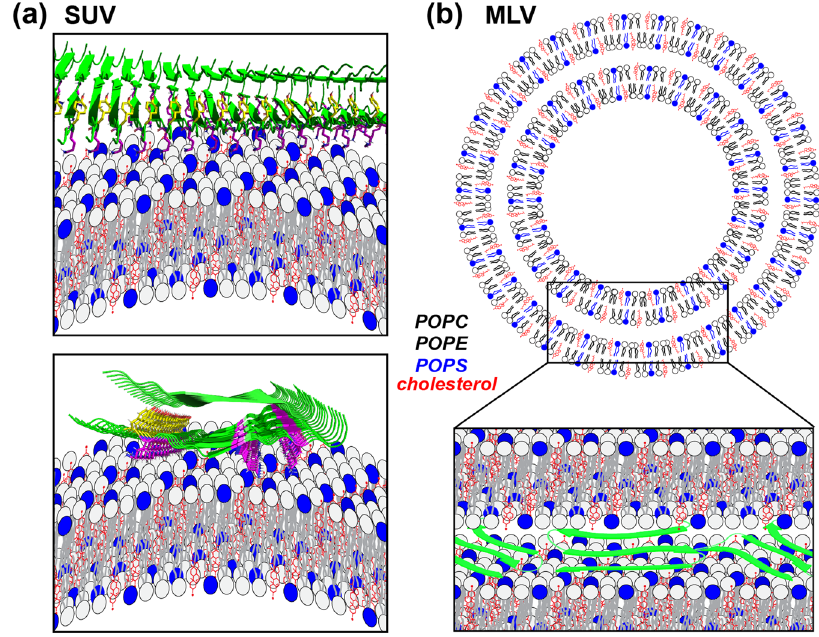
Fig. 6 Model of membrane-induced tau β -sheet assembly. a Binding tau monomers to preformed cholesterol-containing SUVs promote the formation of amyloid fi brils that contain the hexapeptide motif VQIVYK in the R3 domain. These fi brils are immersed at the membrane-water interface, without inserting into the hydrophobic interior. Key Lys sidechains may face the lipid phosphates to stabilize tau interactions with the lipid membrane. The crucial Y310 residue (yellow) is hypothesized to stack with sidechains from another β -sheet. b Tau-lipid co-assembled multilamellar vesicles induce β -strands between adjacent bilayers, without forming ordered amyloid fi